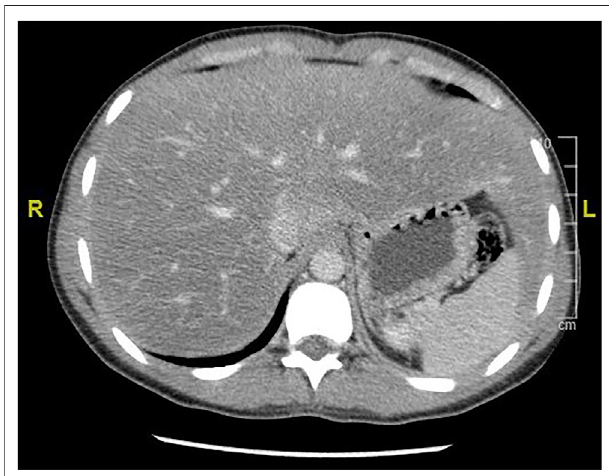
FIGURE 3 | CT imaging features of liver steatosis. Caption: Transverse CT image of the liver showing decreased density of the liver compared to the spleen in this 38-year old patient with NAFLD. In GlyH, the inverse image can be witnessedwithincreaseddensity compared tothe spleen, but due to concomitant steatosis, this contrast is potentially attenuated in metabolic patients.